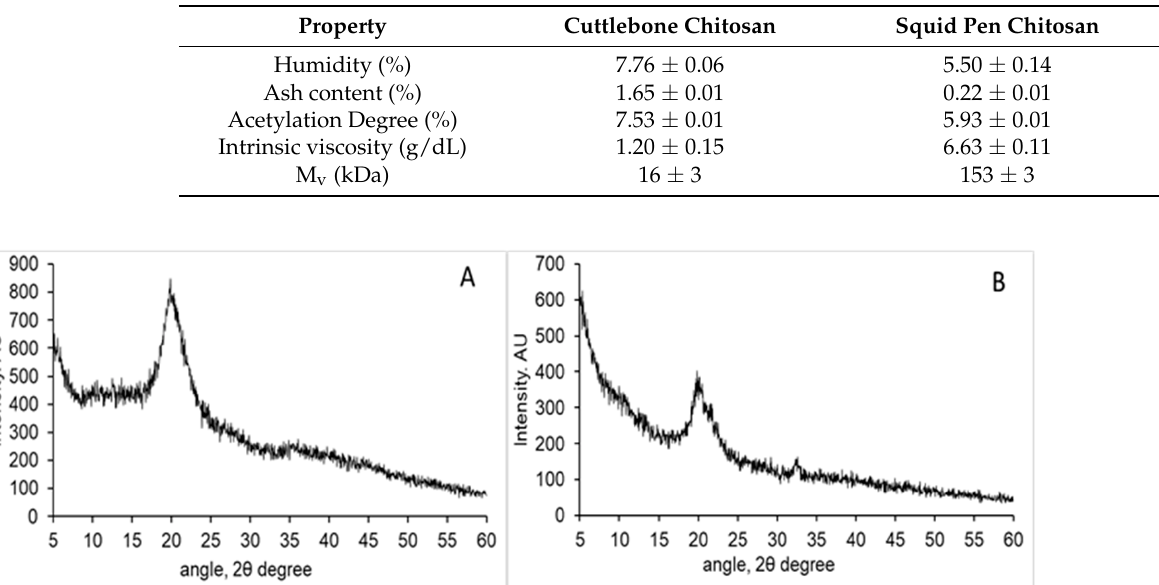
Figure 2. XRD pattern of squid pen chitosan ( A ) and cuttlebone chitosan ( B ). The ATR-FTIR spectra of both chitosan samples were quite similar as seen in Figure 3. Both spectra exhibited three main spectral regions. A first region appears as a broad asymmetric band between 3400 and 2500 cm − 1 due to the CH stretching modes at around 2927 and 2867 cm − 1 and, at higher wavenumbers (around 3229 cm − 1 ), bands corresponding to the overlapped O-H and N-H stretching vibrations; the second region appears between 1700 and 1200 cm − 1 and it is characteristic of the amide groups (amide I at 1650 cm − 1 ), finally, the third region appears as a strong absorption region between 800 and 1200 cm − 1 characteristic of the chitosan saccharide structure In particular, bands at 1154 and 1074 cm − 1 are attributed to C-O-C stretching vibration modes [35].